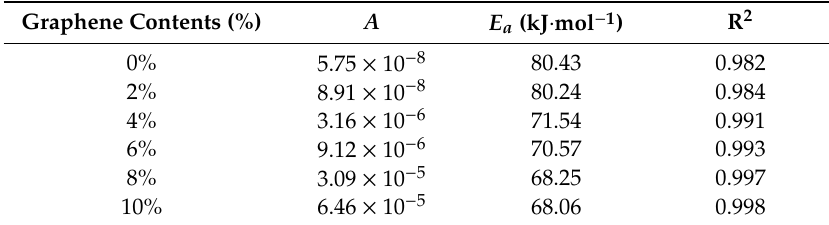
Table 3. A and E a in Arrhenius equation for control asphalt and GMAs and R 2